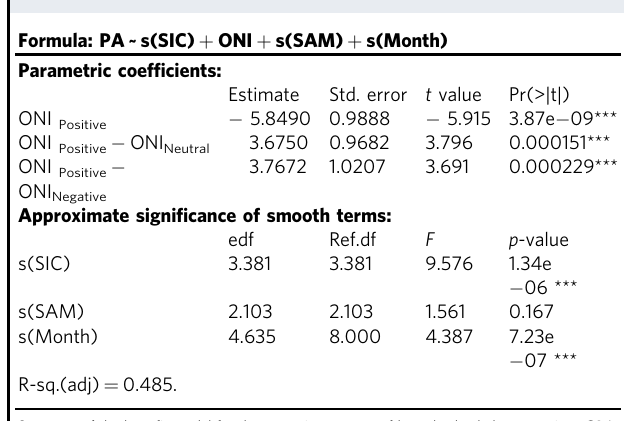
Table 1 Results of best- fi t